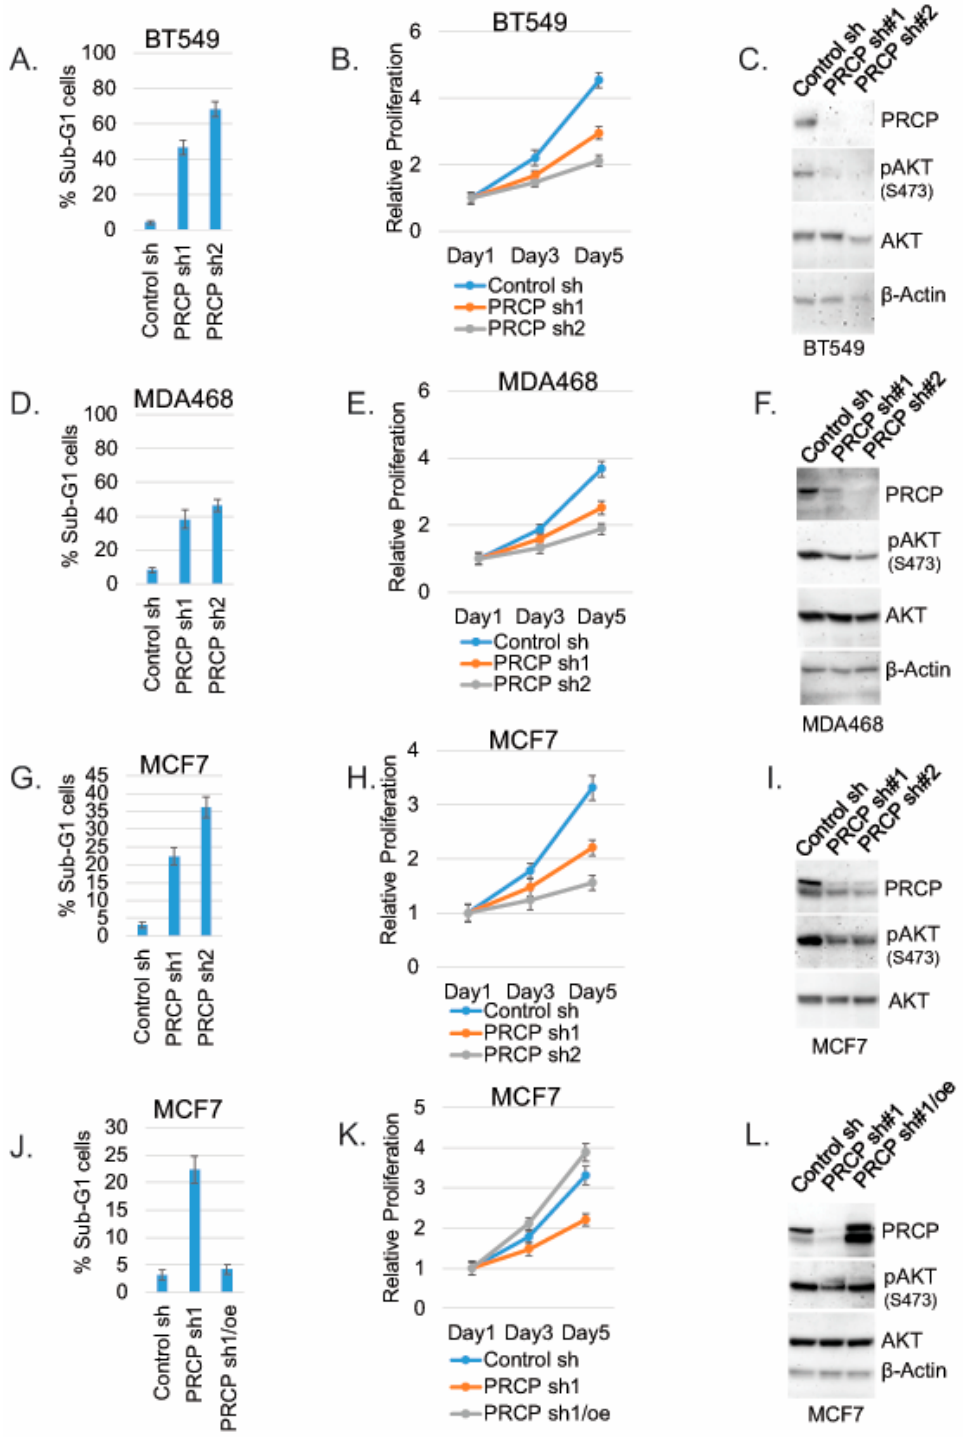
Figure 2. PRCP promotes cell survival, proliferation, and AKT activation. BT549, MDA468, and MCF7 cells were transduced with lentiviral PRCP shRNA (sh1, sh2) or control shRNA. The cells were analyzed with Flow Cytometry for Sub-G1 (apoptosis) at day 5. Average (triplicate) % apop- totic cells is shown ( A ),( D ),( G ). Proliferation was monitored in transduced cells for 5 days by Hoechst staining DNA. Average results from 4 experiments are shown ( B ),( E ),( H ). Lysates were immunoblotted for the indicated proteins ( C ),( F ),( I ). MCF7 cells were transduced with PRCP sh1 alone or together with a WT PRCP cDNA (PRCPre) ( J )–( L ). The cells were analyzed for Sub-G1,